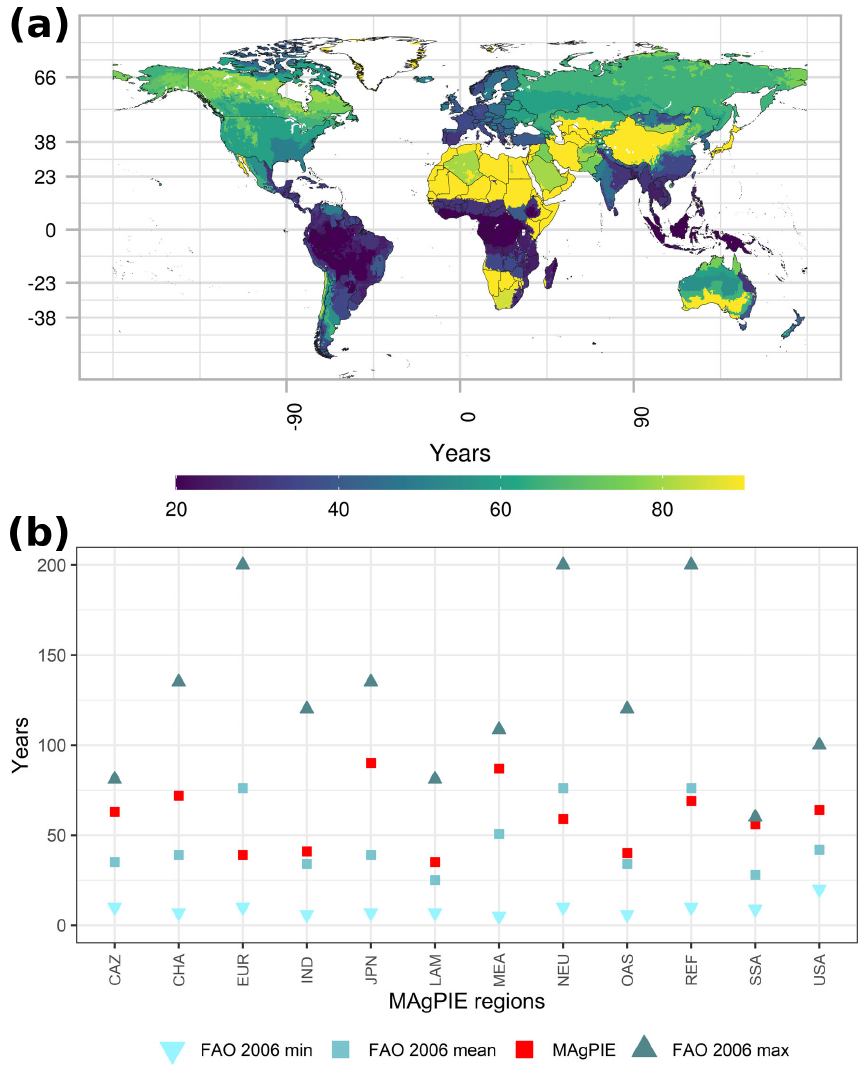
Figure 4. (a) Spatially explicit regional rotation lengths for plantations used in MAgPIE (the rotation length in years is indicated by color). (b) Validation of the rotation length used in MAgPIE with data from FAO